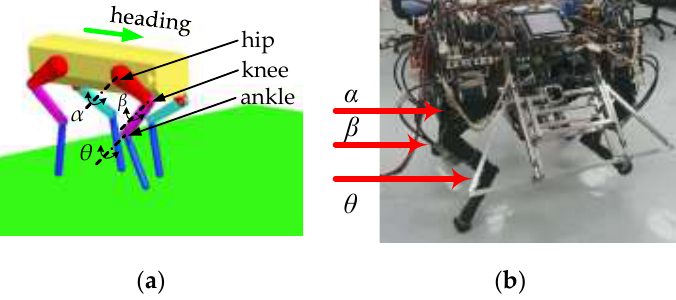
Figure 13. Quadruped robot. ( a ) Simulation prototype of quadruped robot. ( b ) Experimental prototype of quadruped robot.